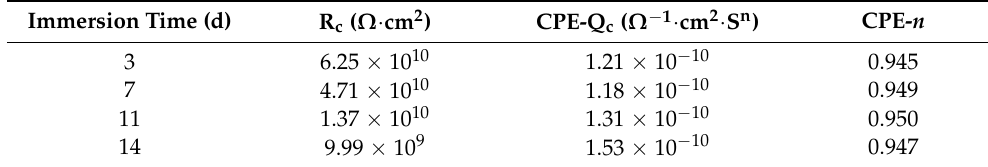
Figure 10. The handheld digital microscope images of the entire WBE surface at the initial state ( a ) and after the immersion in the T. funiculosus -contained medium for 14 days ( b ). The morphologies of the #85 electrode surface and its magnification ( c , d ) and #18 electrode surface and its magnification ( e , f ) after 14 days of immersion. Table 3. EIS fitting results of the #18 electrode immersion in the T. funiculosus -contained medium for different